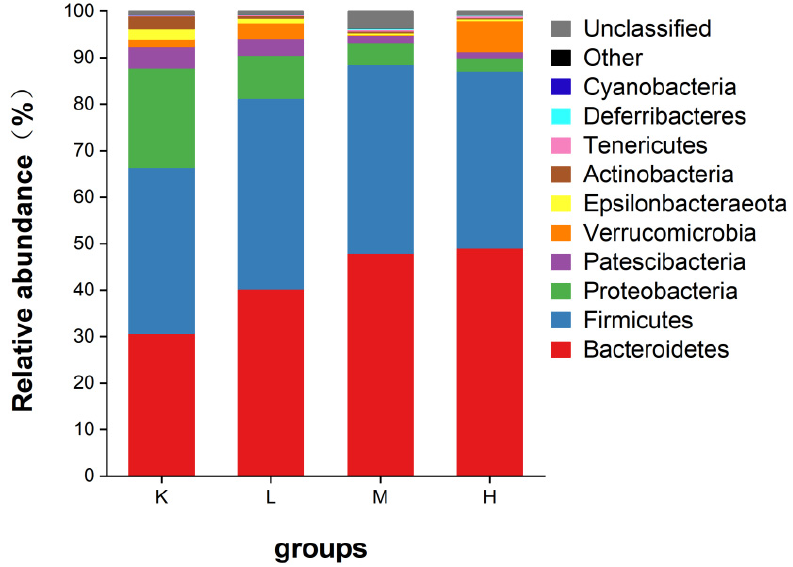
Figure 7. Relative abundance of gut microflora phylum levels in mice.